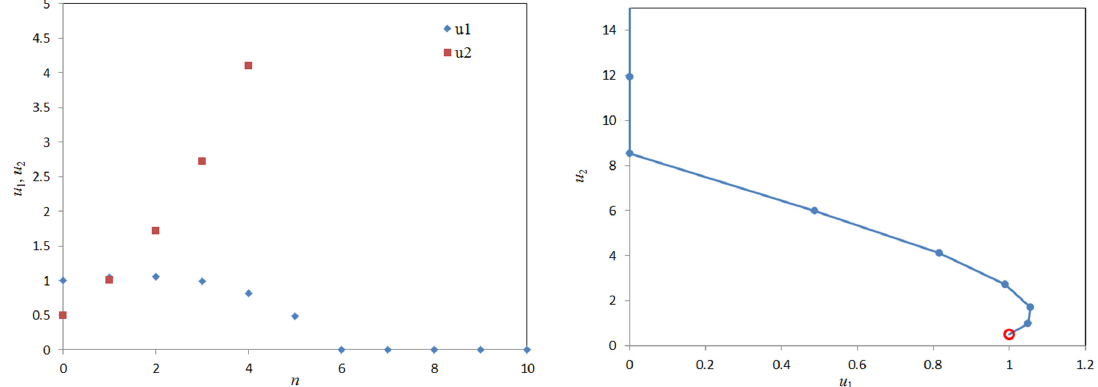
Figure 11. Dependencies 𝑢 (cid:2869) (cid:4666)𝑡(cid:4667) and 𝑢 (cid:2870) (cid:4666)𝑡(cid:4667) ( left ) and the phase trajectory of the worker ‐ employer conflict ( right ) for 𝑢 (cid:2869)(cid:4666)(cid:2868)(cid:4667) (cid:3404) 1; 𝑢 (cid:2870)(cid:4666)(cid:2868)(cid:4667) (cid:3404) 0.5; 𝑘 (cid:2869)(cid:2869) (cid:3404) (cid:3398) 0.3; 𝑘 (cid:2870)(cid:2870) (cid:3404) 0.1; 𝑘 (cid:2869)(cid:2870) (cid:3404) (cid:3398) 0.4; and 𝑘 (cid:2870)(cid:2869) (cid:3404) (cid:3398) 0.1 ( 0 ) = 1; u ( 0 ) = 0.5; k = − 0.3; k = 0.1; k = − 0.4; and k = − 0.1 conflict ( right ) for u 22 11 12 21 ( | 𝜆 | (cid:3404) 1.25; 𝜃 (cid:3404) 34.66). The discrepancy 𝑢 (cid:2869) corresponds to the worker while the discrepancy 𝑢 (cid:2870) 2 1 ( | λ | = 1.25; θ = 34.66). The discrepancy u 1 corresponds to the worker while the discrepancy u 2 corresponds to the employer. corresponds to the